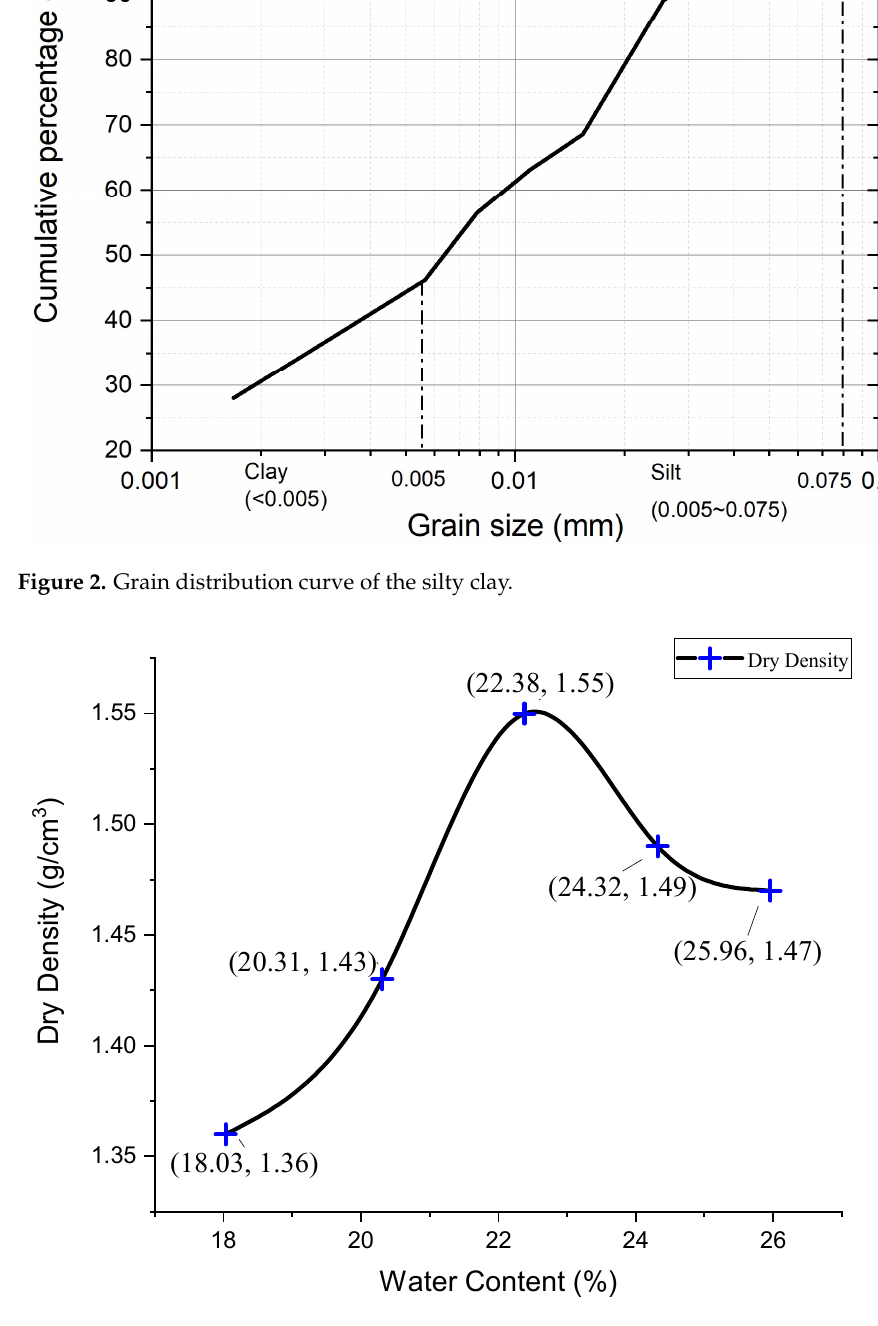
Figure 3. The ρ d - W curve of compaction test.